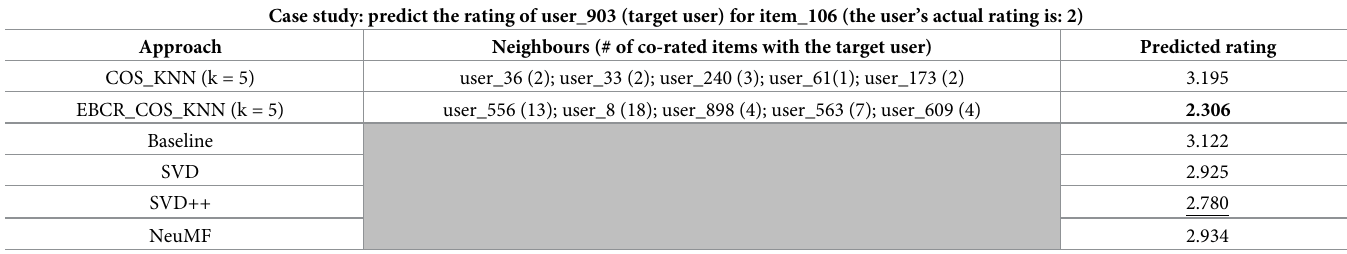
The best prediction approach is bolded and the second ranking one is